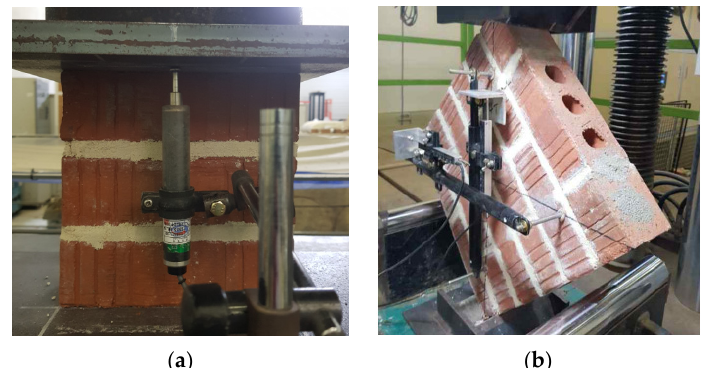
Figure 1. Test setup for determining strengths of masonry prisms: ( a ) Compressive strength; ( b ) diagonal tension strength. agonal tension